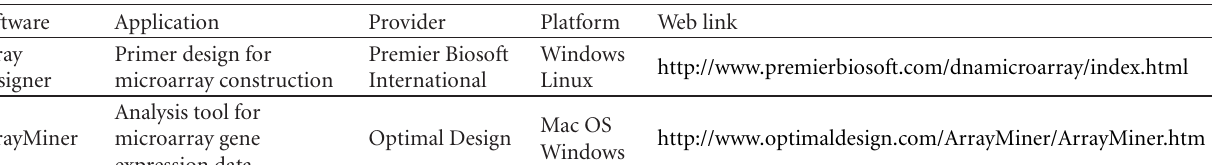
Table 1: Current software applications for microarray data